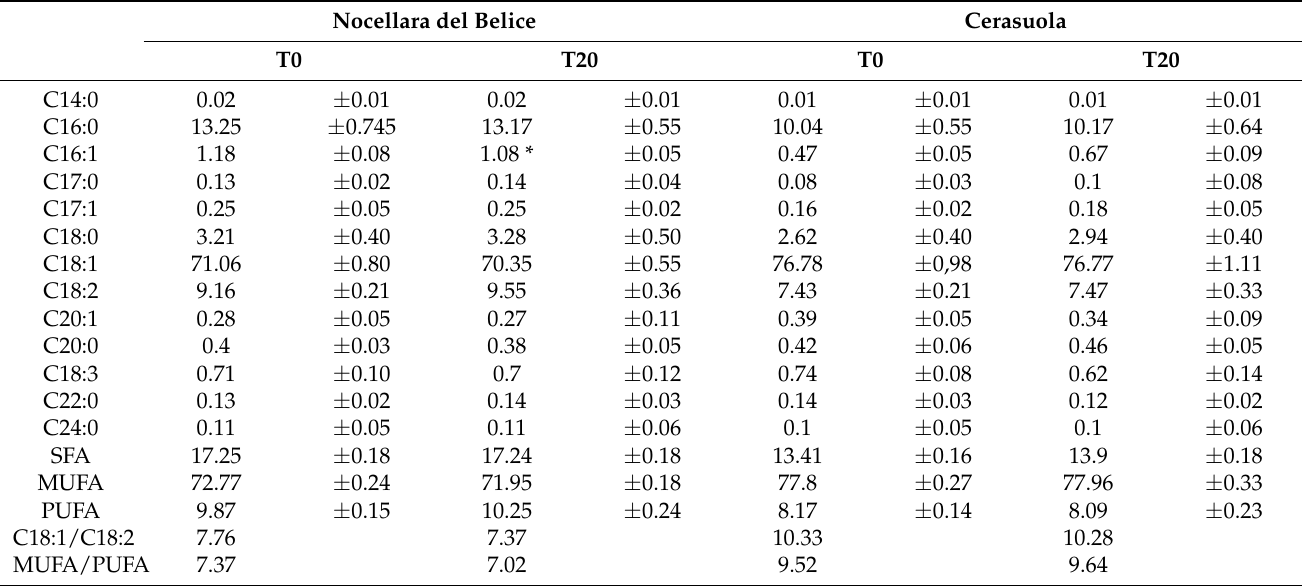
Table 7. Fatty acid profile (mean ± SD) of Nocellara del Belice and Cerasuola EVOOs for tests T0 (unmodified malaxation) and T20 (modified malaxation, with the application of the SCADA platform). Data are expressed in %.